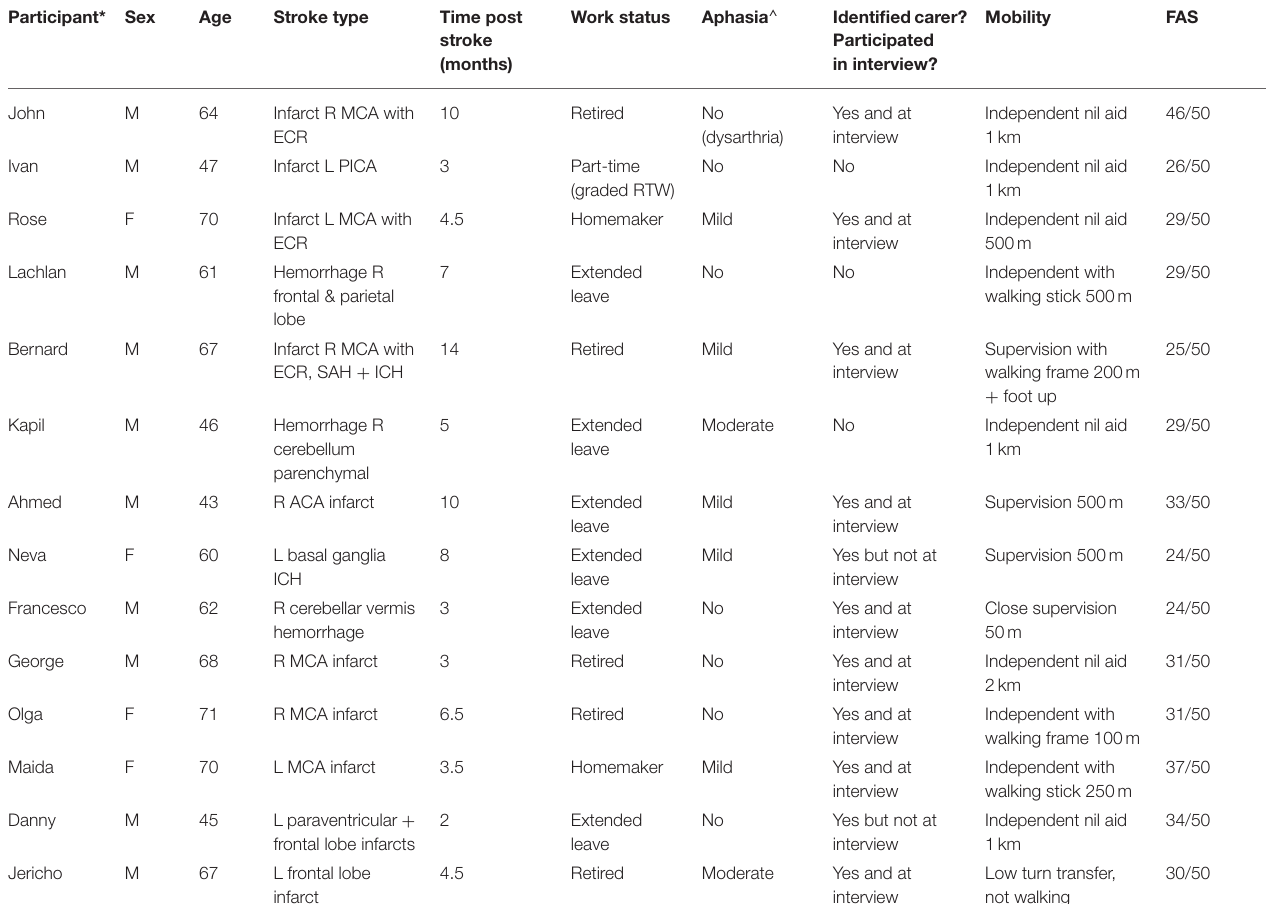
TABLE 1 | Demographic and health